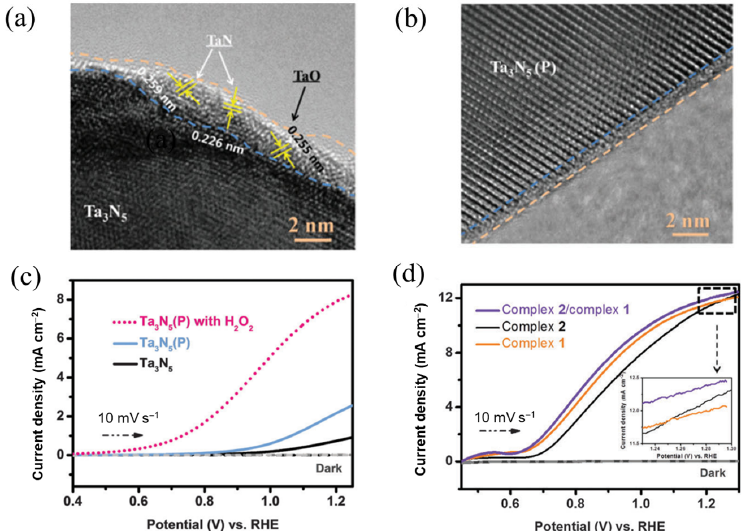
Figure 7. ( a ) The HRTEM image of the as ‐ prepared Ta 3 N 5 photoanode. ( b ) HRTEM image of